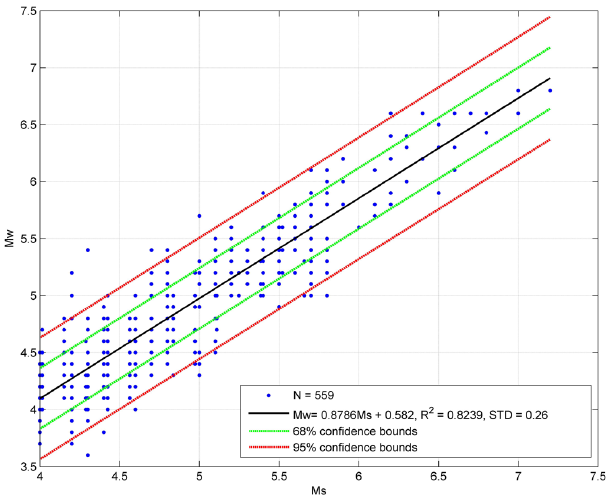
Fig. 1. Moment magnitudes M w vs. surface wave magnitude M s of the Greek catalogue.